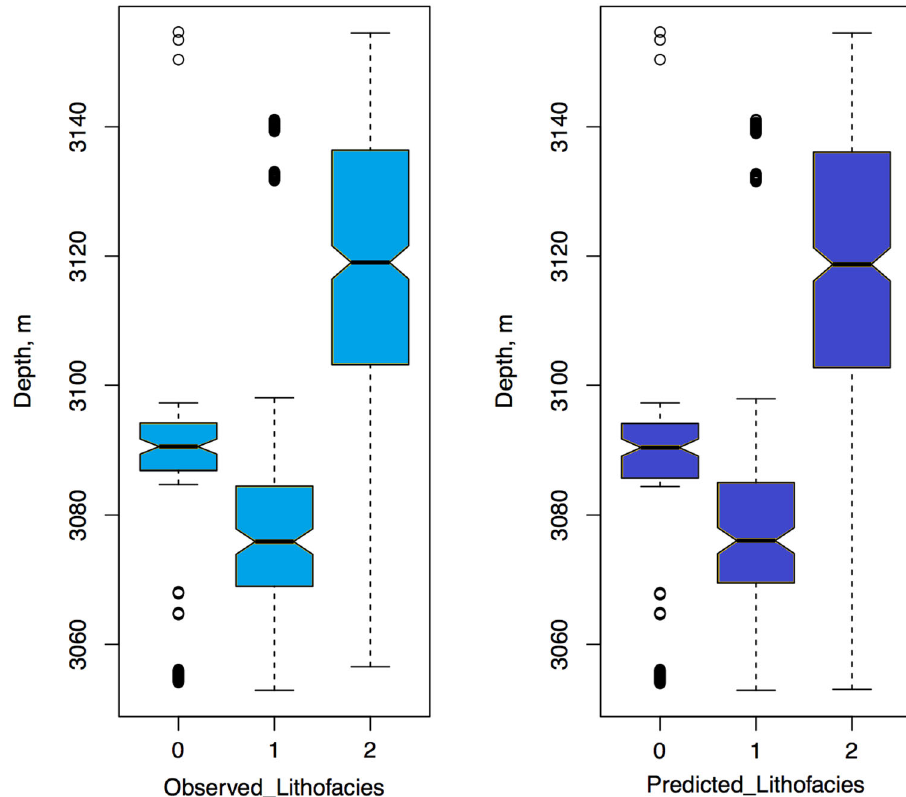
Fig. 4 Box-plots of the observed and predicted discrete lithofacies by the PNN